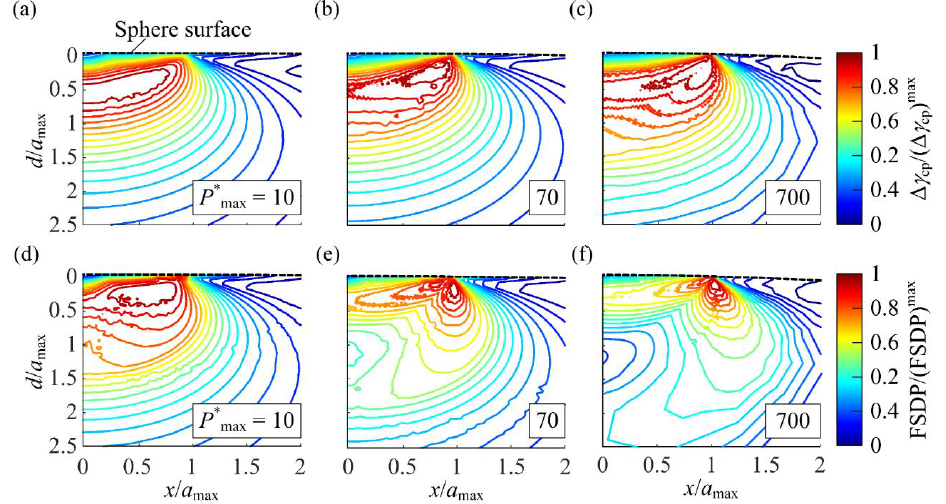
Figure 6. The contour of ( a ) ∆ γ cp /( ∆ γ cp ) max and ( d ) FSDP/(FSDP) max at the sphere tip for P * max = 10. ( b , e ) The same content as in ( a , d ), where P * max = 70. ( c , f ) The same content as in ( a , d ), where P * max = 700.